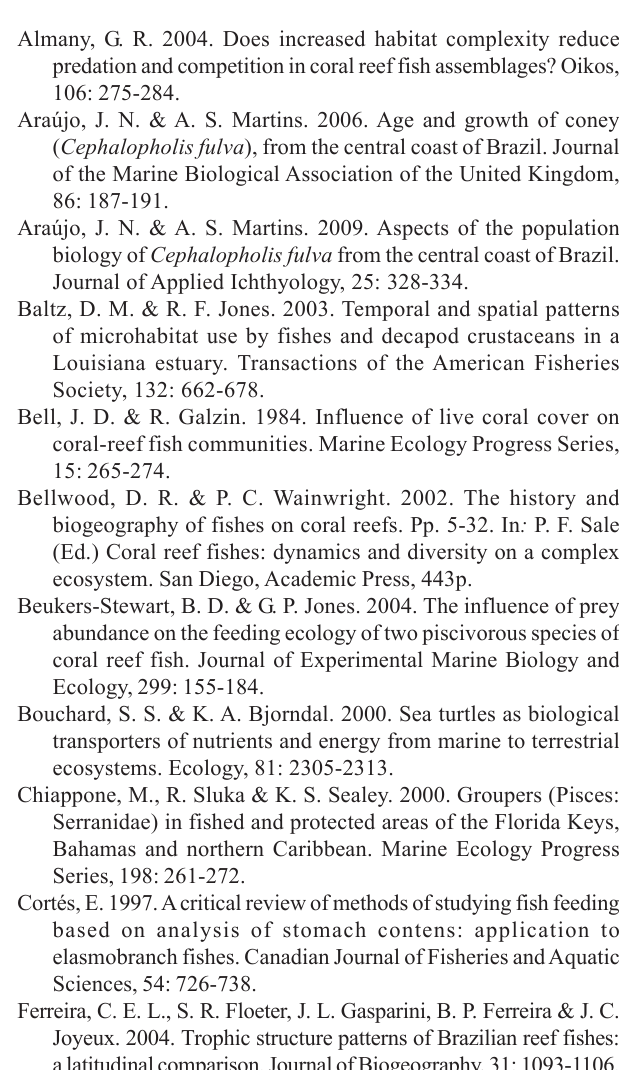
Fig. 5. Frequency of occurrence (% FO) and weight (% W) of food items present in C. fulva ’s gut content at Trindade Island, Brazil.